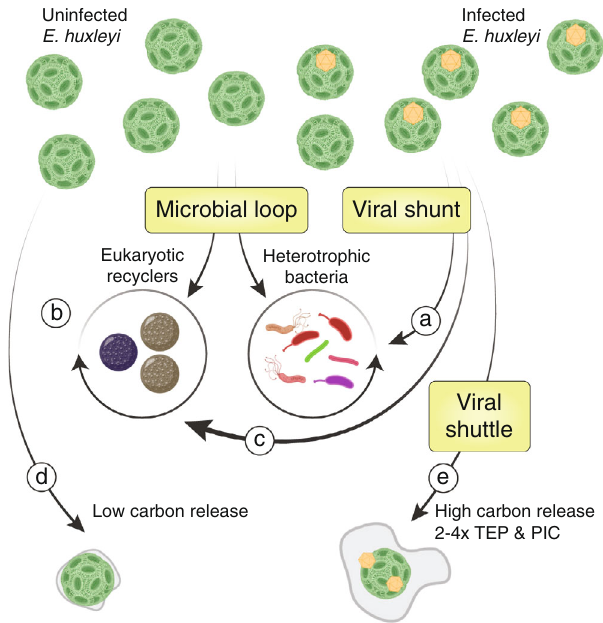
Fig. 5 | Consequences of viral infection on microbial community composition andcarboncycling.a Thebacterialandeukaryoticmicrobiomesareremodeledin response to viral infection only when level of infection is high. b Thraustochytrid rival bacteria as signi fi cant recyclers of organic matter during E. huxleyi demise. c Thraustochytrids bene fi t from viral infection of E. huxleyi . d When the demise is notvirus-associated, E.huxleyi cellsreleaseasmallamountoforganicandinorganic carbon. e Viral infection increases E. huxleyi cells carbon release between 2 and 4-fold under the form of TEP and PIC as compared to ( d ). Arrows represent the direction of carbon fl ow. Created with